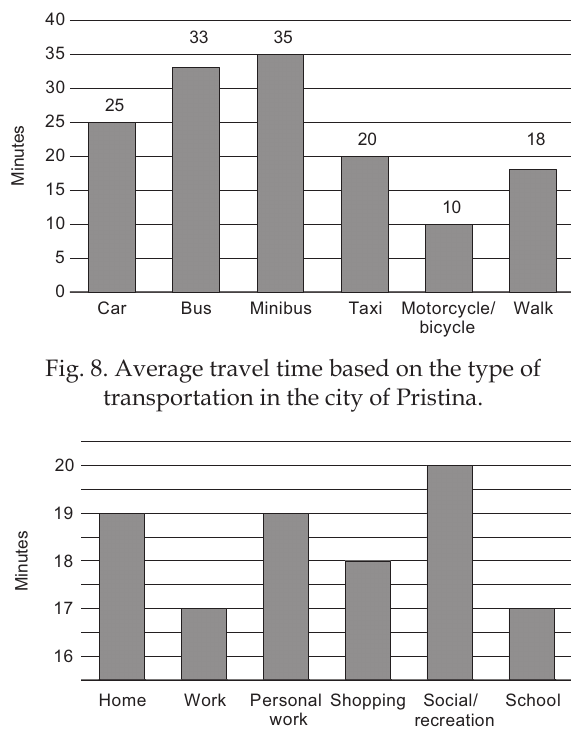
Fig. 9. Average travel time based on purpose in the city of Pristina.